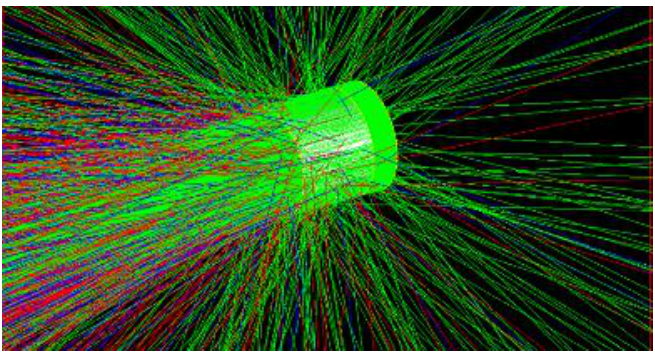
Figure 14. Track structure produced by gammas irradiating SDD.